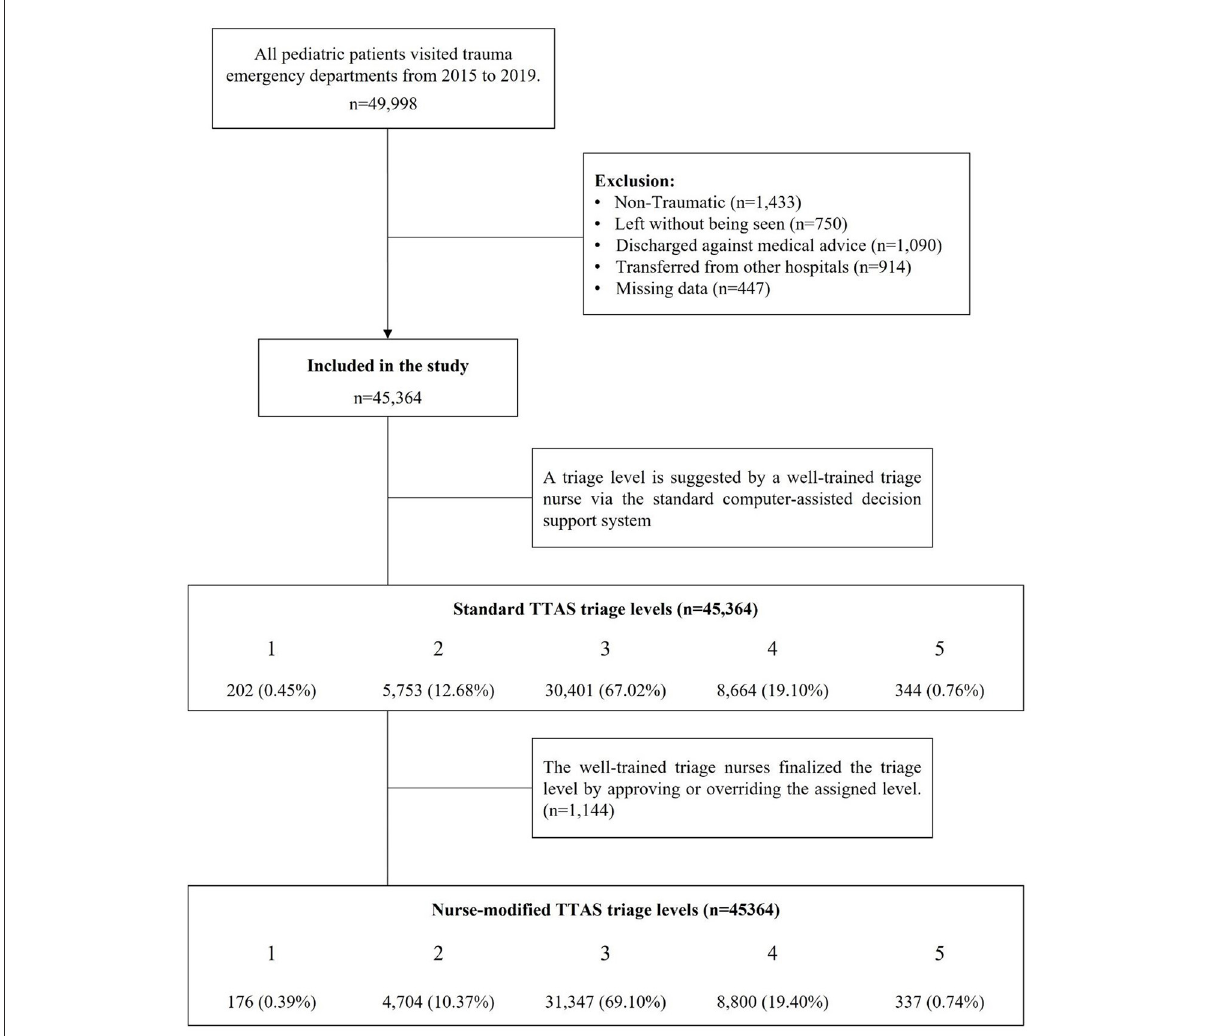
FIGURE1 Process for inclusion and exclusion of pediatric traumatic patients visited the EDs, 2015 to 2019. TTAS, Taiwan Triage and Acuity Scale; ED, emergency